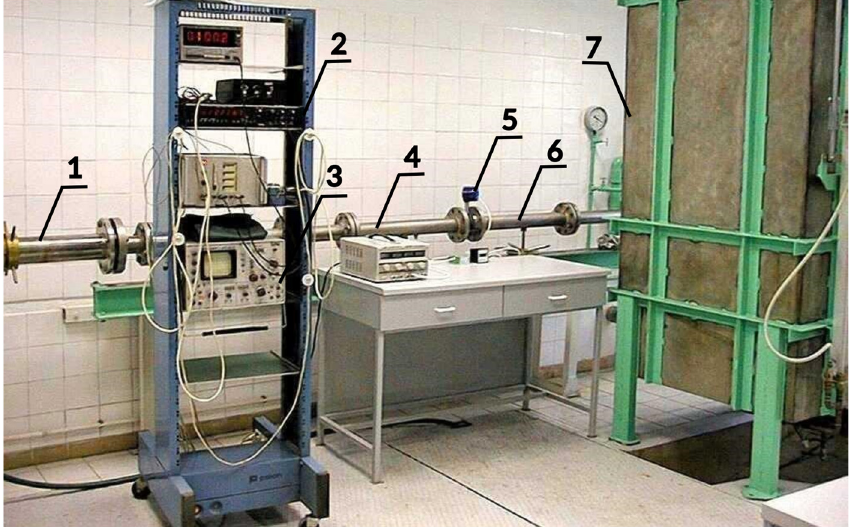
Figure 5. Water calibration stand with an installed mechanical oscillator flowmeter. 1—telescopic compensator, 2—pulse counter, 3—oscilloscope, 4—upstream pipe, 5—mechanical oscillator flowmeter, 6—downstream pipe, 7—measurement tank.